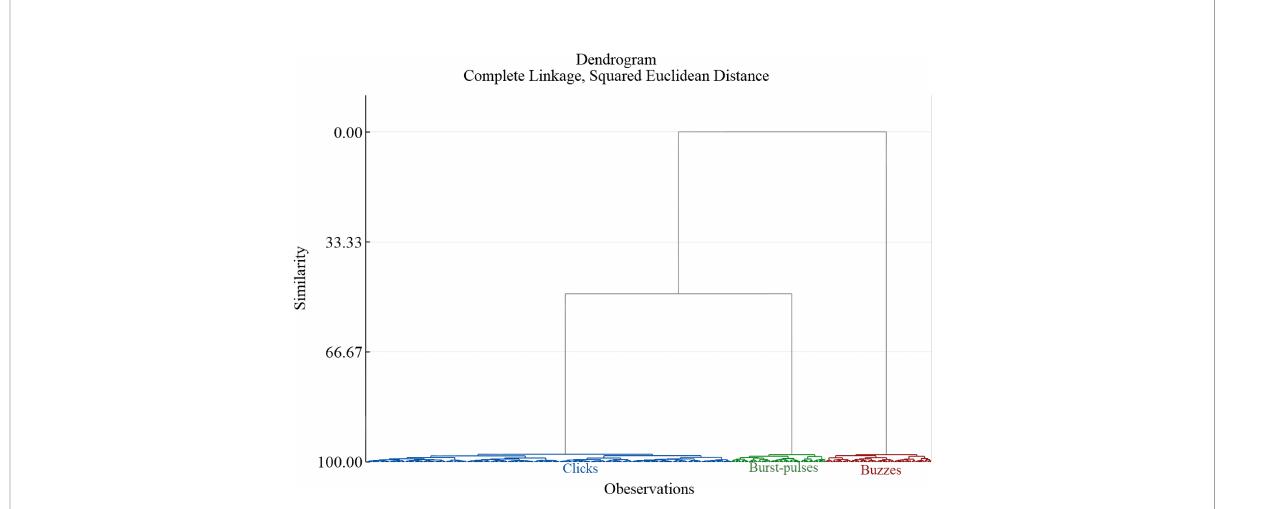
FIGURE 2 Dendrogram obtained for the pulsed signal trains recorded from Indo-Paci fi c humpback dolphins based on hierarchical cluster analysis. Different main clusters (similarity over 95%) are shown in different